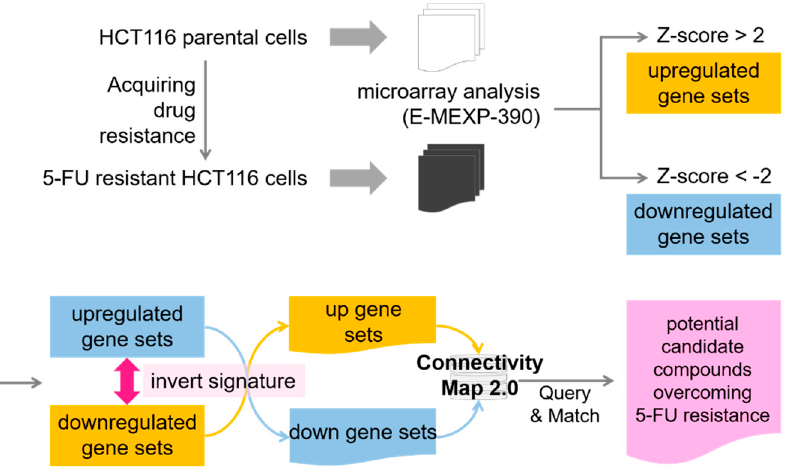
Figure 4. Pattern matching analysis to reveal drugs able to overcome APC-independent 5-FU resistance. The differentially expressed genes from 5-FU-resistant and parental HCT116 cells were defined and inverted to match the drug-responsive gene expression pattern in the Connectivity Map 2.0 database. The drugs triggering negatively correlated gene expression patterns are reported as potential candidate compounds overcoming 5-FU resistance.